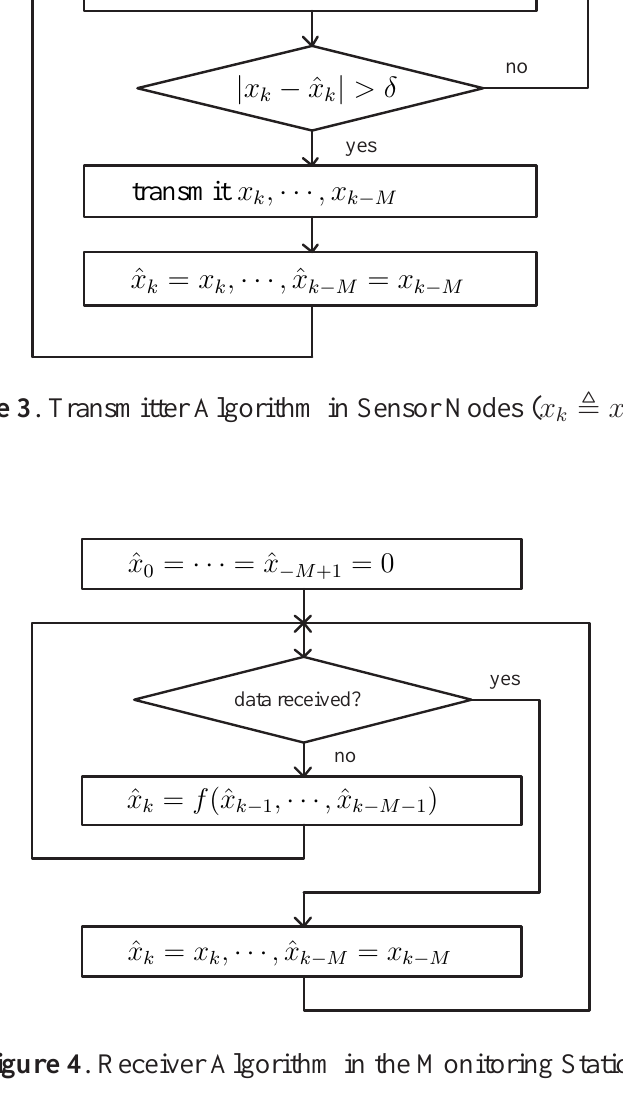
Figure 4 . Receiver Algorithm in the Monitoring